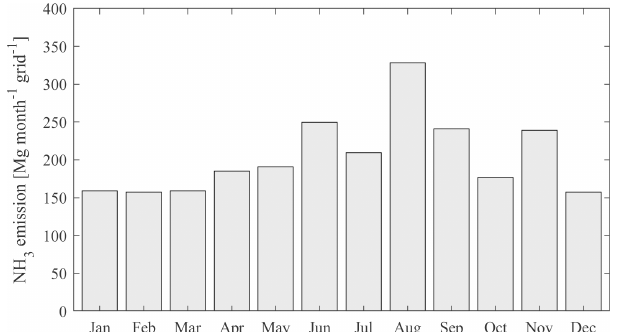
Figure 4. Time series of NH 3 emissions over the NCP region pro- vided by MICS-Asia III at a horizontal resolution of 45km from January to December in the year